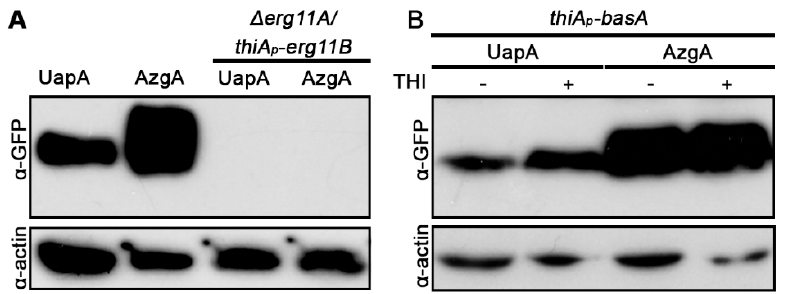
Figure 4. ( A ) UapA and AzgA steady state levels in erg11 and ( B ) basA knockdown mutants. Western blot analysis of UapA-GFP or AzgA-GFP steady state levels using total protein extracts and monoclonal anti-GFP antibody. Actin antibody was used to calibrate protein loading. For thiA p -basA , proteins were extracted after ab initio (overnight) thiamine repression of BasA. Transporter expression was driven from native promoters. Notice a moderate increase in the levels UapA or AzgA levels upon basA repression, contrasting the full loss of UapA or AzgA detection when erg11 activities are knocked out.